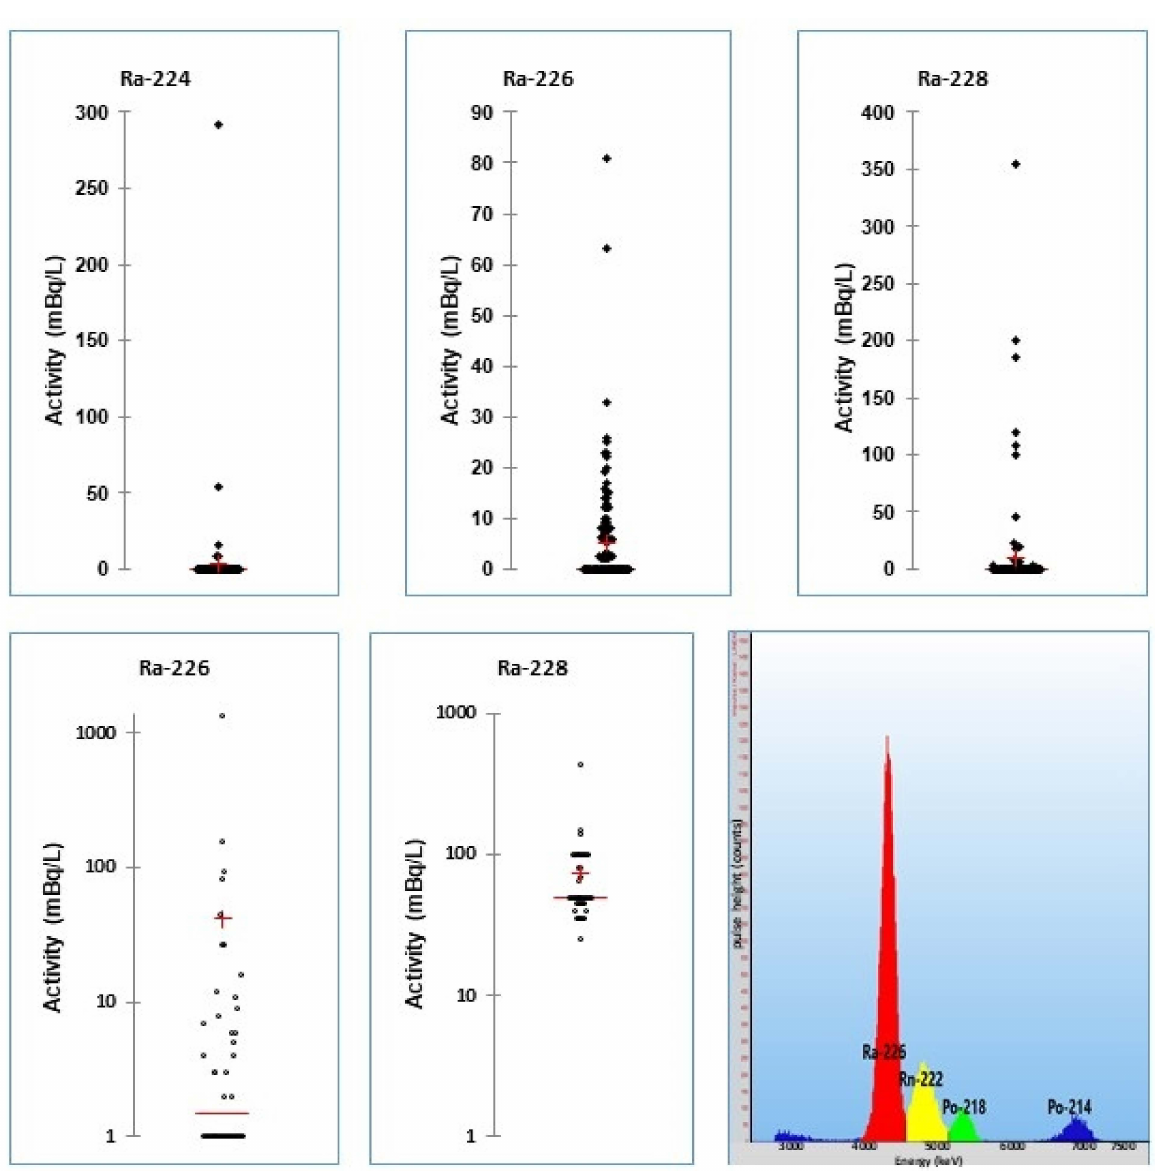
Figure 5. Upper diagrams: scatter diagrams of radium nuclides in tap water. Lower diagrams left and middle: scatter diagrams of radium activities in 46 mineral waters from the Swiss market (from [45]). Right: PERALS spectrum of a RADAEX extract of the mineral water PEDRAS, showing 224 Ra, 226 Ra and daughters. The PEDRAS mineral water contains about 1.4 Bq/L 226 Ra and 110 mBq of 224 Ra